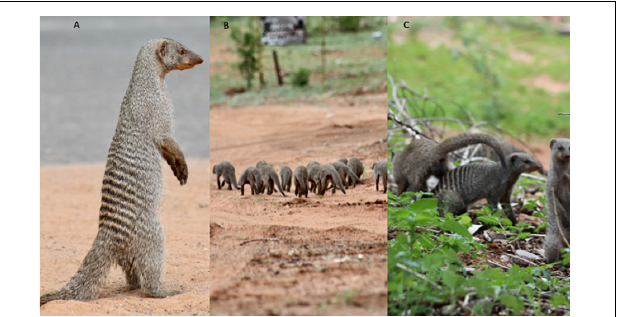
TABLE 5 | Parameter estimates of our best supported glmm model (based on AIC w i ) for banded mongoose olfactory communication in Northern Botswana. FIGURE 3 | (A) Vigilance, (B) flight, and (C) scent marking behavior in a banded mongoose study troop.